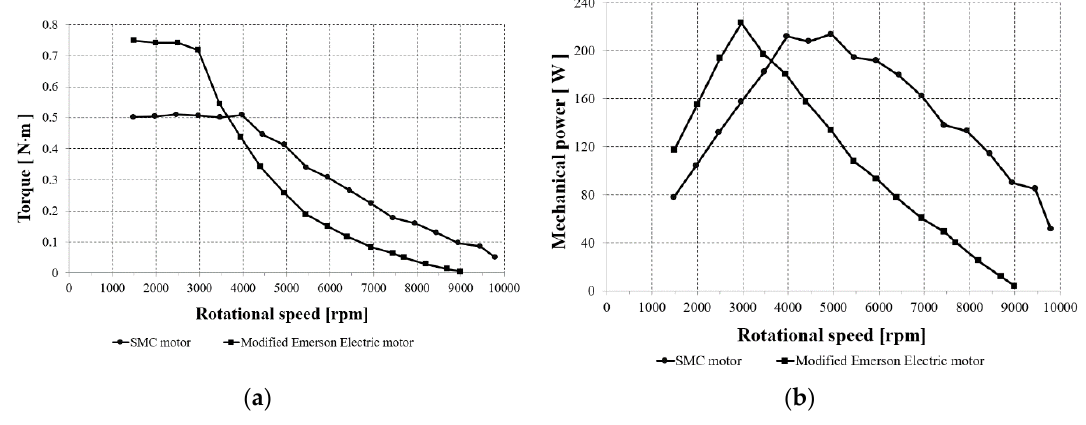
Figure 7. ( a ) Torque vs. rotational speed for the prototype and modified Emerson Electric motors; ( b ) mechanical power vs. rotational speed for the prototype and modified Emerson Electric motors, U DC = 310 V.